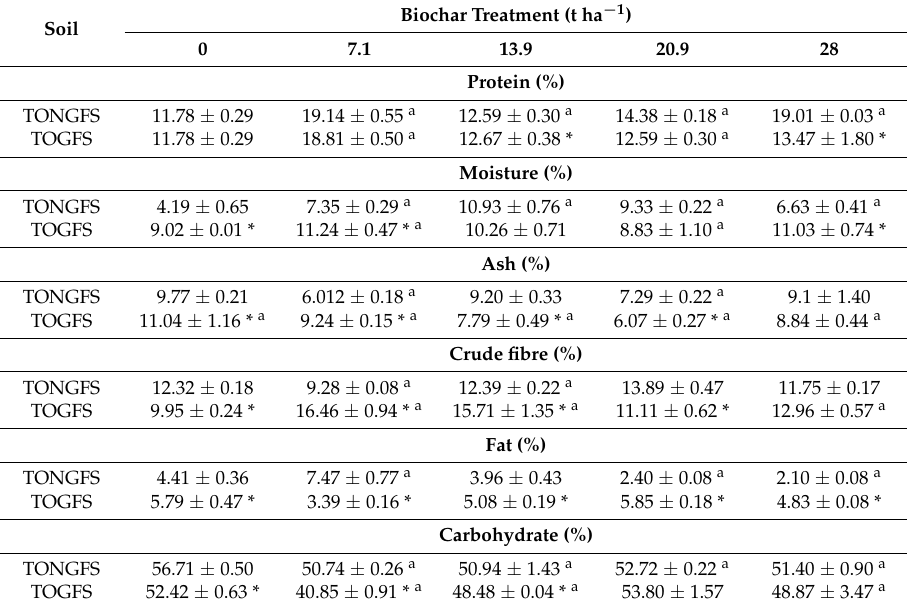
Table 4. Effect of biochar remediation on the proximate composition of T. occidentalis leaves cultivated on gas flared and non-gas flared